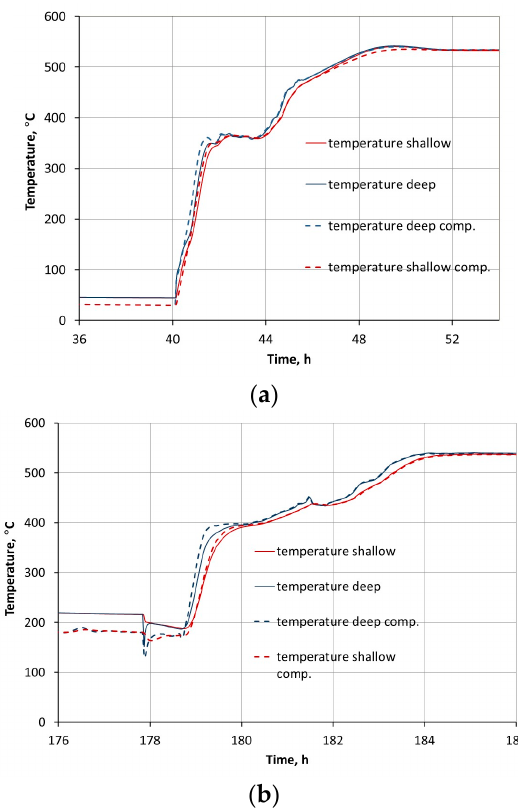
Figure 9. Comparison of temperature changes determined with the FEM and those measured at the selected points of the junction; calculations were made for a constant value of α = 3000 W/m 2 K: ( a ) startup from the cold state, ( b ) startup from the hot state. ( a ) startup from the cold state, ( b ) startup from the hot state.